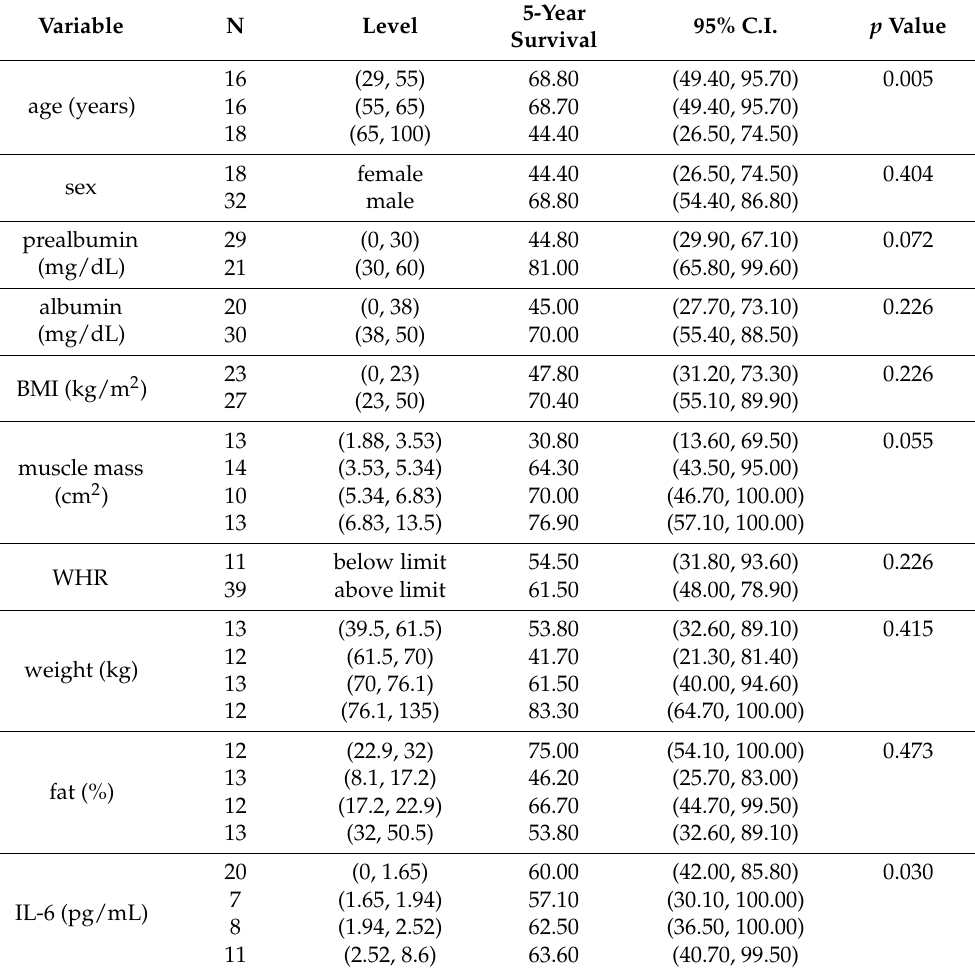
Table 3. Five-year survival estimates according to different parameters ( n =